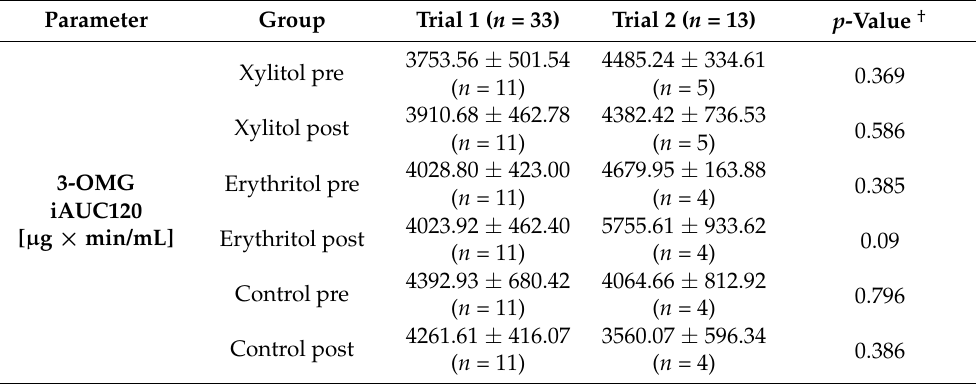
Table 2. Comparison of 3-OMG iAUC120 (mean ± SEM) between the two trials. Parameter